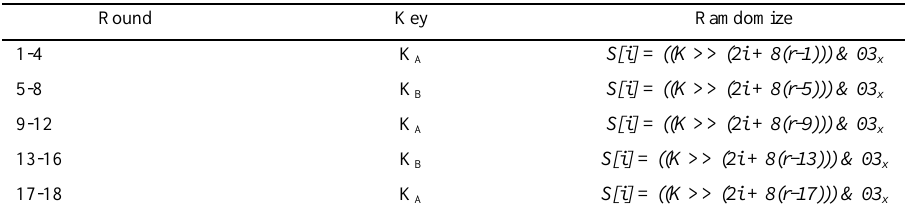
Table 5. The algorithm for selecting SBox Round Key